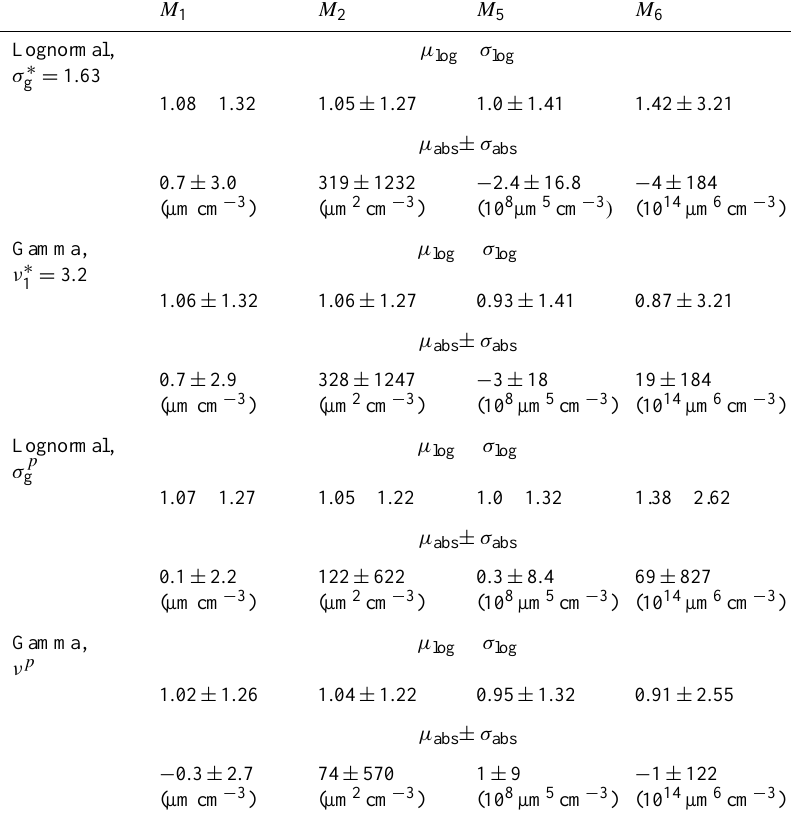
Table 2. Values of the geometric mean µ log and the geometric standard deviation σ log of the log errors, and the arithmetic mean µ abs and the arithmetic standard deviation σ abs of the absolute errors calculated for M 1 , M 2 , M 4 and M 6 , for the lognormal and the gamma parametric functions, when using the constant trade-off tuning parameters values, σ ∗ g and ν ∗ , and the parameterized value as a function of N r q r , σ p g and ν p . M 1 M 2 M 5 σ ∗ g = 1 .